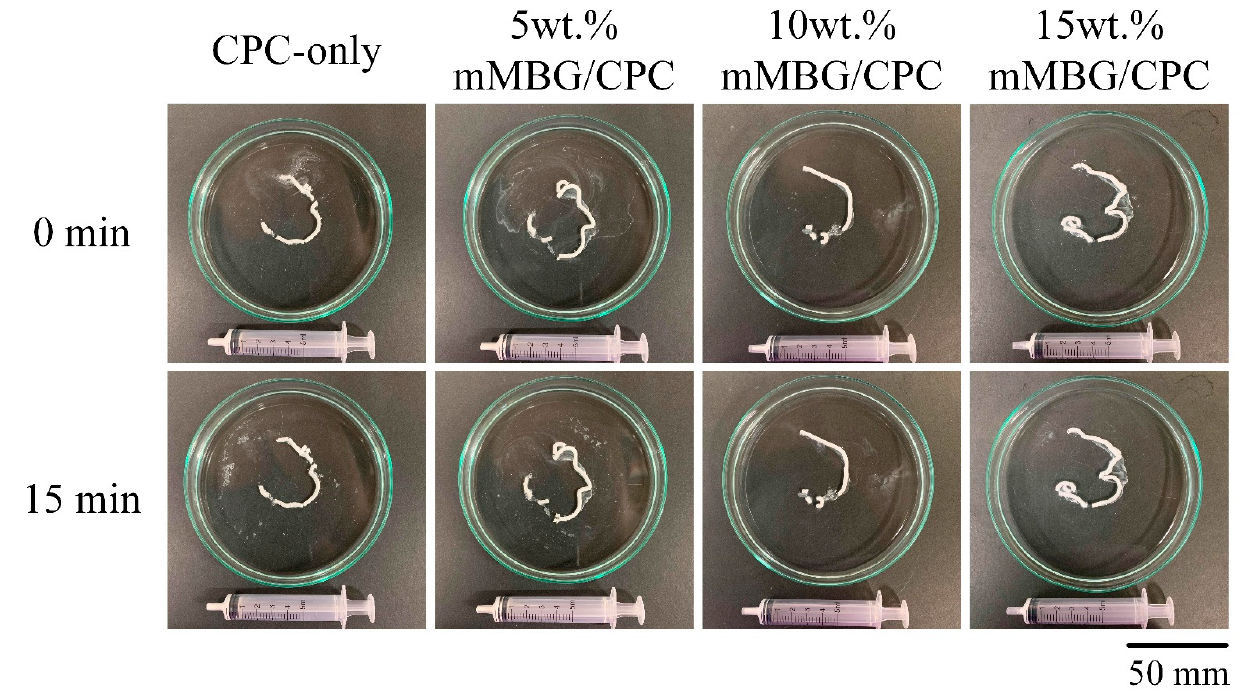
Figure 2. Analysis of slurry injectability ( upper row ) and dispersibility ( lower row ) of CPC-only and mMBG/CPC composite bone cements with different mMBG ratios of 5, 10, and 15 wt.%.